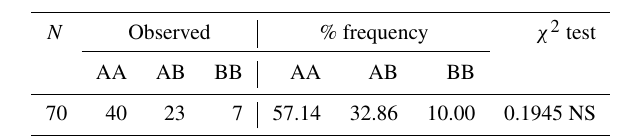
Table 1. CSN3 genotype frequencies and Hardy–Weinberg genetic equilibrium test